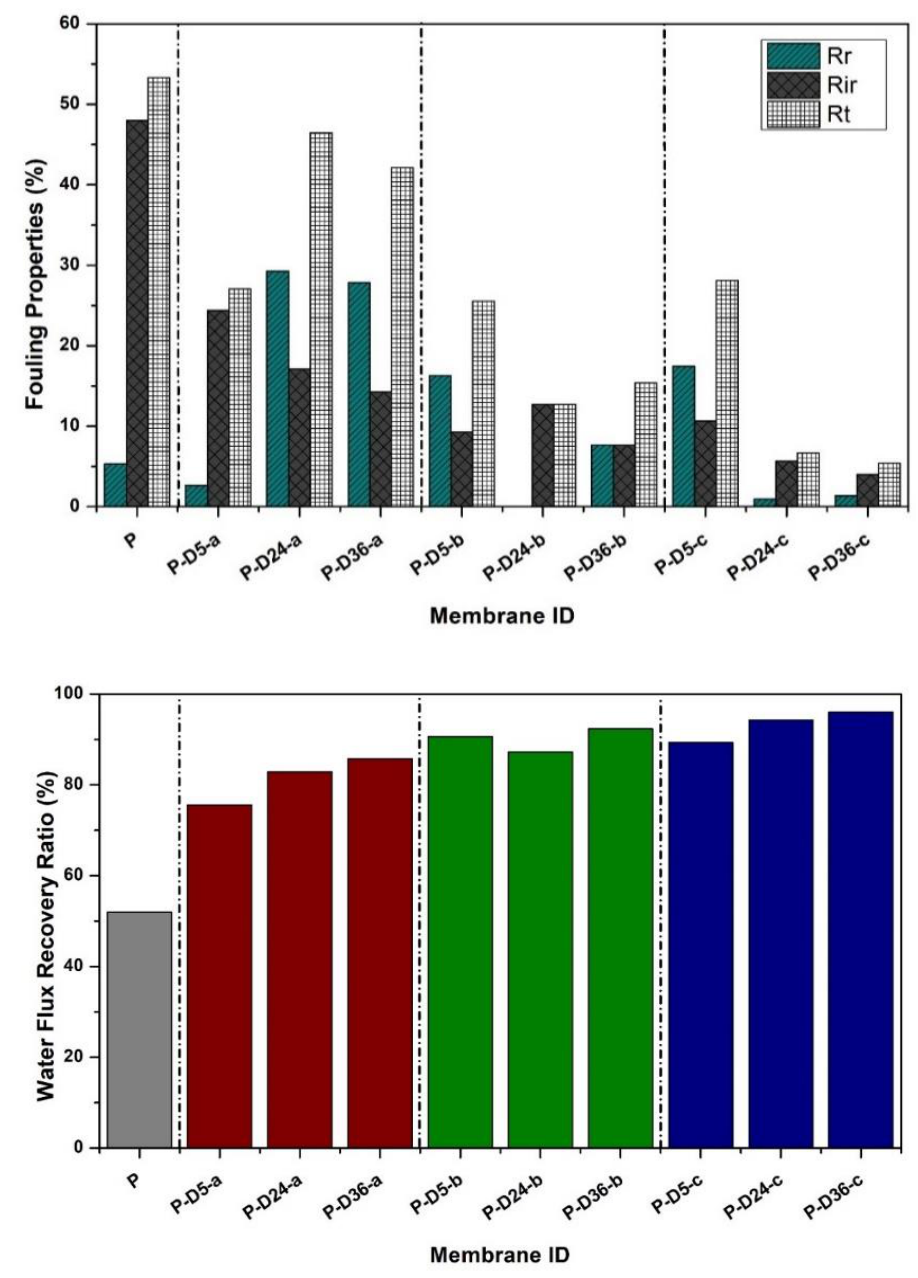
Figure 6. E ff ect of modification on membrane antifouling performance in terms of (top) Rr, Rt, Rir, and (bottom) the FRR.